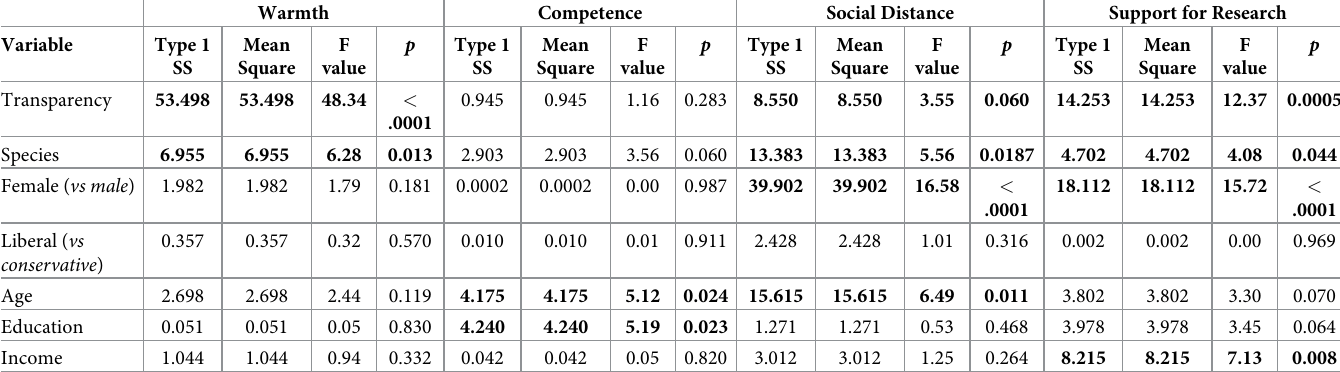
Table 3. Effect of participant demographics (gender, political leaning, age, education, and income) on composite responses to questions designed to assess a) warmth, b) competence, and c) social distance for the hypotheitical lab animal technician “Cathy,” as well as d) support for the research she does. All individual questions were asked on a 7 point Likert scale (1 = not at all; 7 = extremely); responses for each of the composite measures below were averaged across individual questions. The effects of participant demographics on these responses are shown by coefficients (slope (B) and S.E.), and the t-value and corresponding probability that these values differ from 0. These values are from general linear model that also included the main effects of transparency and species, and the relevant 2-way interactions. Bold values indicate p = <